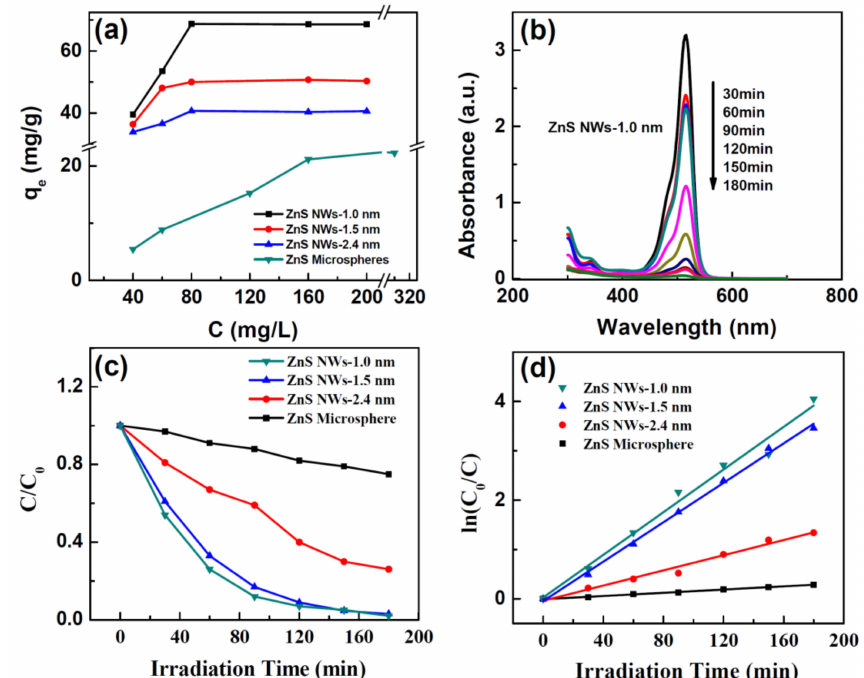
Figure 6. ( a ) The equilibrium adsorption capacity of the as-prepared ZnS USNWs of different diameters towards Eosin B as a function of its concentration; ( b ) temporal evolution of UV-vis absorption spectra of a Eosin B solution (5.0 × 10 − 5 M) in the presence of the ZnS nanowires of 1.0 nm in diameter (3.0 mg) as the catalyst with different exposure periods to UV irradiation; ( c ) normalized concentration of Eosin B in the testing solutions as a function of the illumination time in the presence of various catalysts (e.g., the ZnS USNWs of different diameters or ZnS microspheres); ( d ) plots of ln( C 0 / C ) of the Eosin B solution under test versus irradiation time, displaying the fitting results using the pseudo-first-order reaction